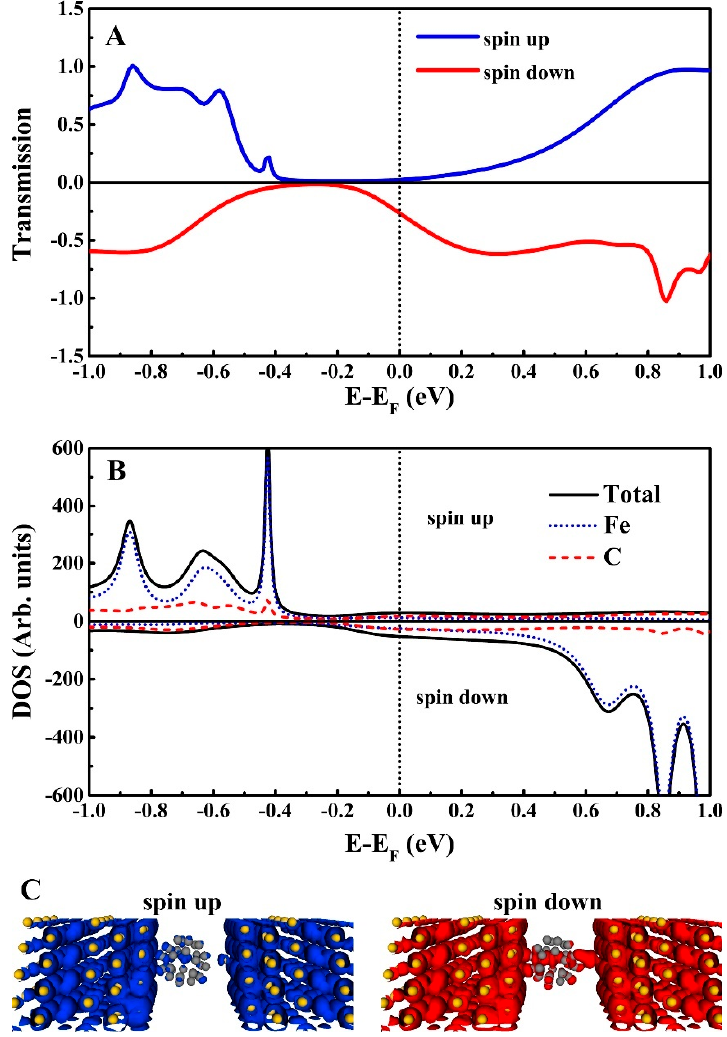
Figure 5. Transport properties of the Fe@C 28 junction. Au tip and Fe@C 28 are non-bonding. ( A ) Spin-resolved transmission spectra of the Fe@C 28 junction. ( B ) Spin-resolved DOS projected on two C atoms that are nearest to the Au tip, a C–C bond adsorbed on the Au(111), and endohedral Fe, respectively. Black line: total DOS; dot: Fe; virtual line: C. ( C ) Profile of the spin-resolved local DOS at the Fermi level, which suggests that the spin-down electrons can offer an effective conductance channel at E F .